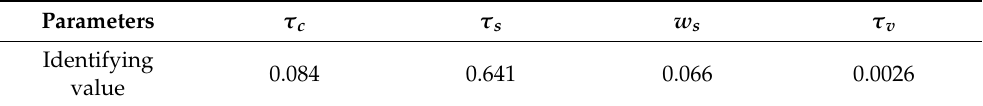
Table 2. Stribeck model identification parameter values.